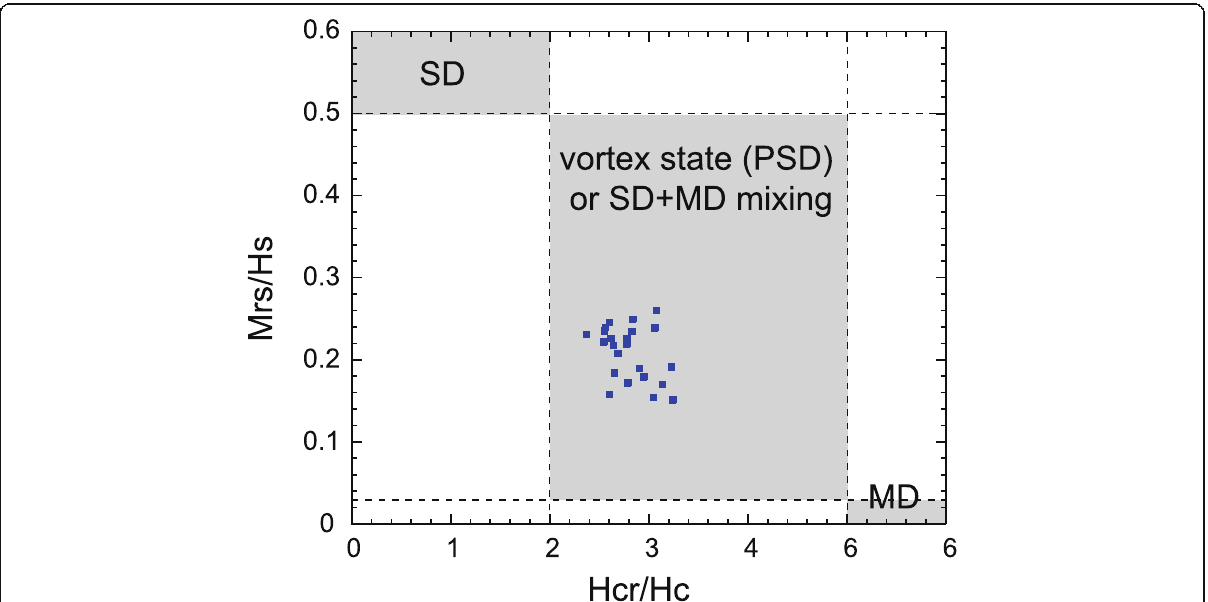
Fig. 4 Rock-magnetic results. Day diagram of hysteresis parameters from selected specimens. SD single domain, PSD pseudo-single domain, MD multi-domain. Domain state boundaries are drawn after Dunlop